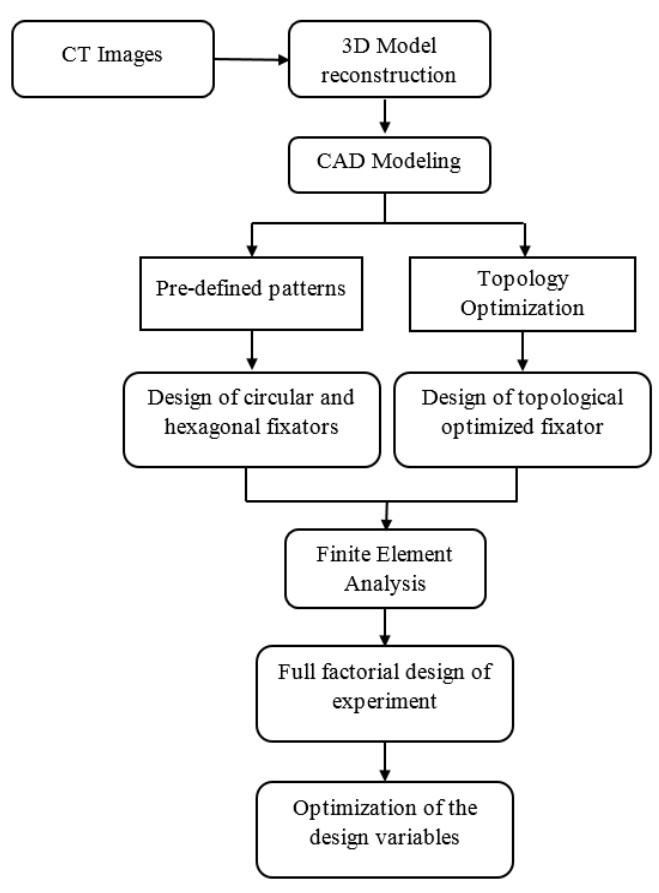
Figure 1. Methodology to design and optimization a personalized external fixation system.